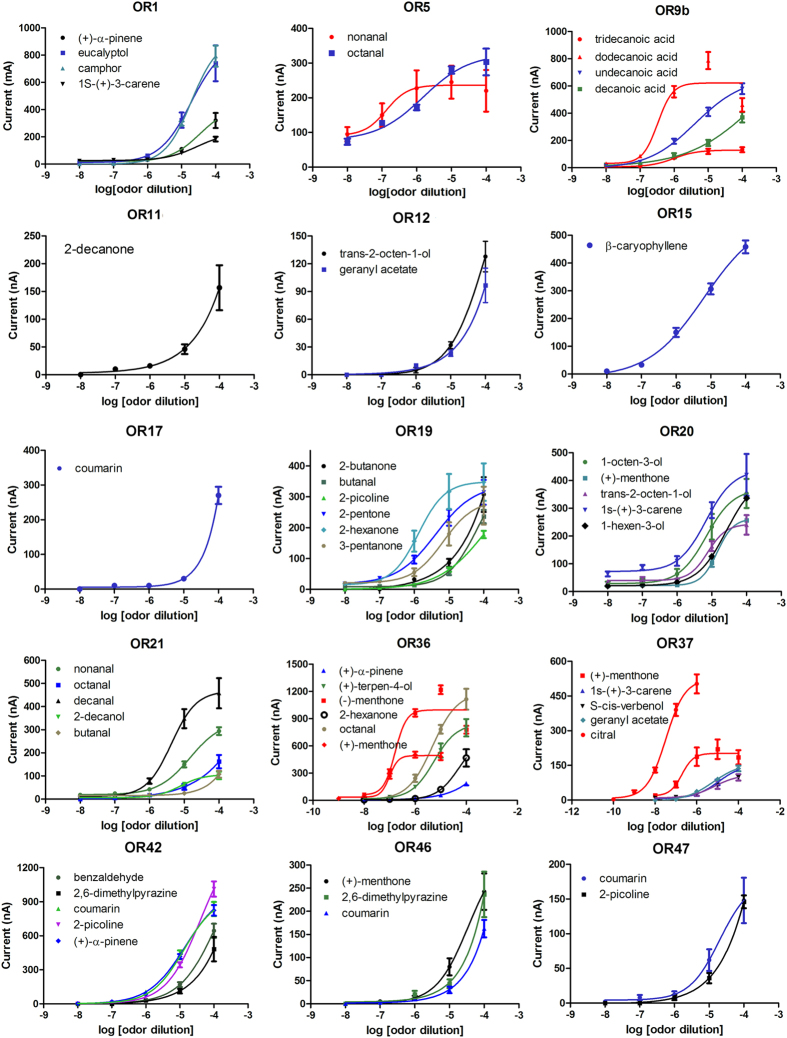
Dose-dependent responses.Dose-response curves of ORs to different odorants (means ± SEM, n = 3–6). EC50 values are expressed as dilutions of pure reagents in Ringer’s solution15. Red dose–response curves indicate ligands whose EC50 values are in the range of 10−7 dilution or below. OR1: (+)-α-pinene, EC50 = 3.41 × 10−5; eucalyptol, EC50 = 1.88 × 10−5; camphor, EC50 = 1.94 × 10−5; 1s-(+)-3-carene, EC50 = 2.93 × 10−5; OR5: nonanal, EC50 = 1.32 × 10−7; decanal, EC50 = 1.53 × 10−6; OR12: trans-2-octen-1-ol, EC50 = 1.03 × 10−4; OR15: β-caryophyllene, EC50 = 6.46 × 10−6; OR19: butanal, EC50 = 6.56 × 10−5; 2-picoline, EC50 = 1.11 × 10−4; 2-pentanone, EC50 = 4.13 × 10−6; 2-hexanone, EC50 = 1.33 × 10−6; 3-pentanone, EC50 = 6.84 × 10−6; OR20: 1-octen-3-ol, EC50 = 6.95 × 10−6; (+)-menthone, EC50 = 1.44 × 10−5; trans-2-octen-1-ol, EC50 = 7.65 × 10−6; 1s-(+)-3-carene, EC50 = 6.85 × 10−6; 1-hexen-3-ol, EC50 = 2.61 × 10−5; OR21: nonanal, EC50 = 1.48 × 10−5; decanal, EC50 = 4.27 × 10−6; 2-decanol, EC50 = 7.55 × 10−6; OR36: octanal, EC50 = 4.79 × 10−6; (−)-menthone, EC50 = 1.64 × 10−7; (+)-terpen-4-ol, EC50 = 5.49 × 10−6; 2-hexanone, EC50 = 5.12 × 10−5; (+)-menthone, EC50 = 9.92 × 10−8; OR37: citral, EC50 = 3.32 × 10−8; (+)-menthone, EC50 = 1.93 × 10−7; 1s-(+)-3-carene, EC50 = 1.13 × 10−5; S-cis-verbenol, EC50 = 7.10 × 10−6; geranyl acetate, EC50 = 6.01 × 10−6; OR42: coumarin, EC50 = 1.45 × 10−5; 2-picoline, EC50 = 3.89 × 10−5; (+)-α-pinene, EC50 = 1.32 × 10−5; OR46: (+)-menthone, EC50 = 3.46 × 10−5; OR47: coumarin, EC50 = 2 × 10−5.